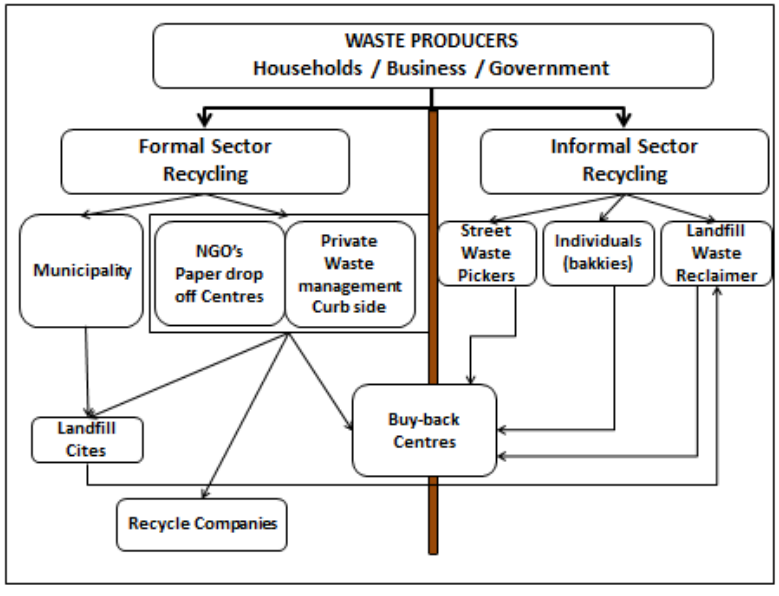
Figure 1: General overview of the waste recycling